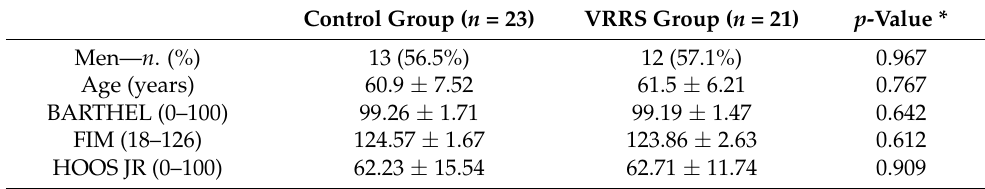
Table 2. Patient characteristics at baseline. Data are reported as means ± standard